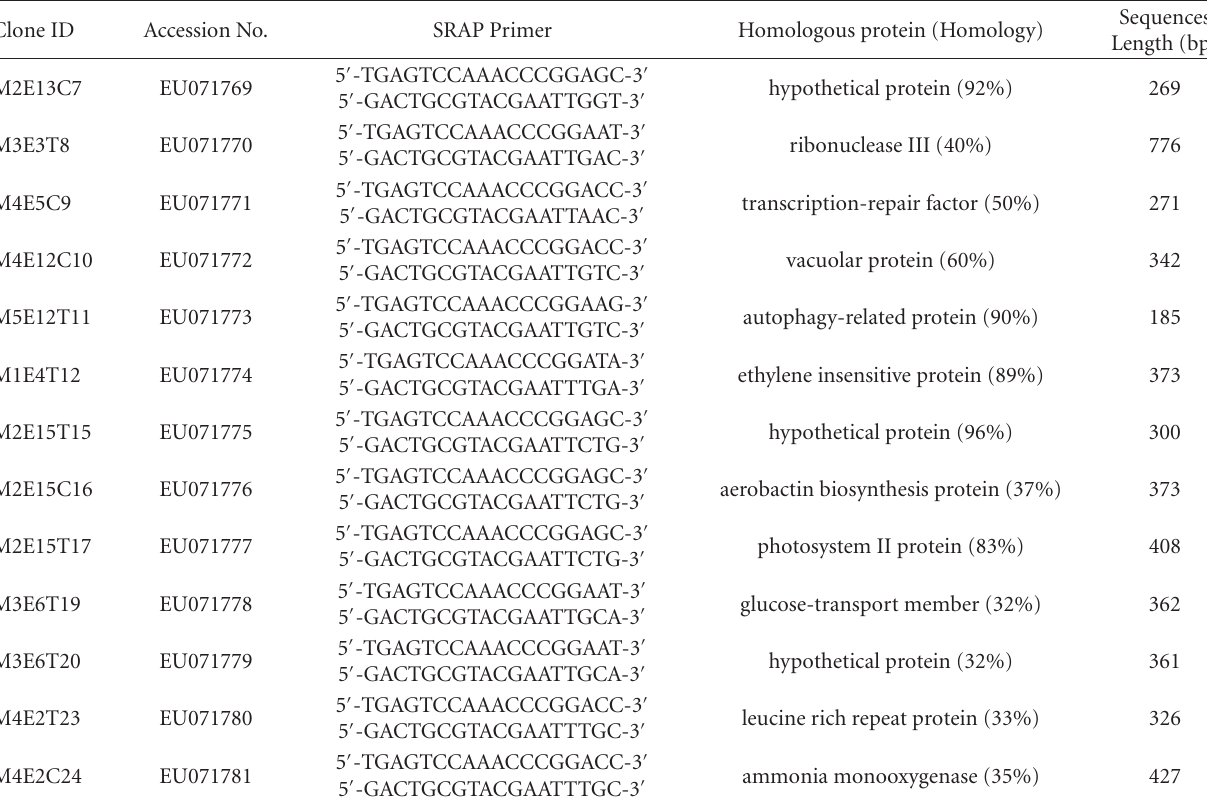
Table 2: Sequence analysis of di ff erential expressed genes screened in cDNA-SRAP